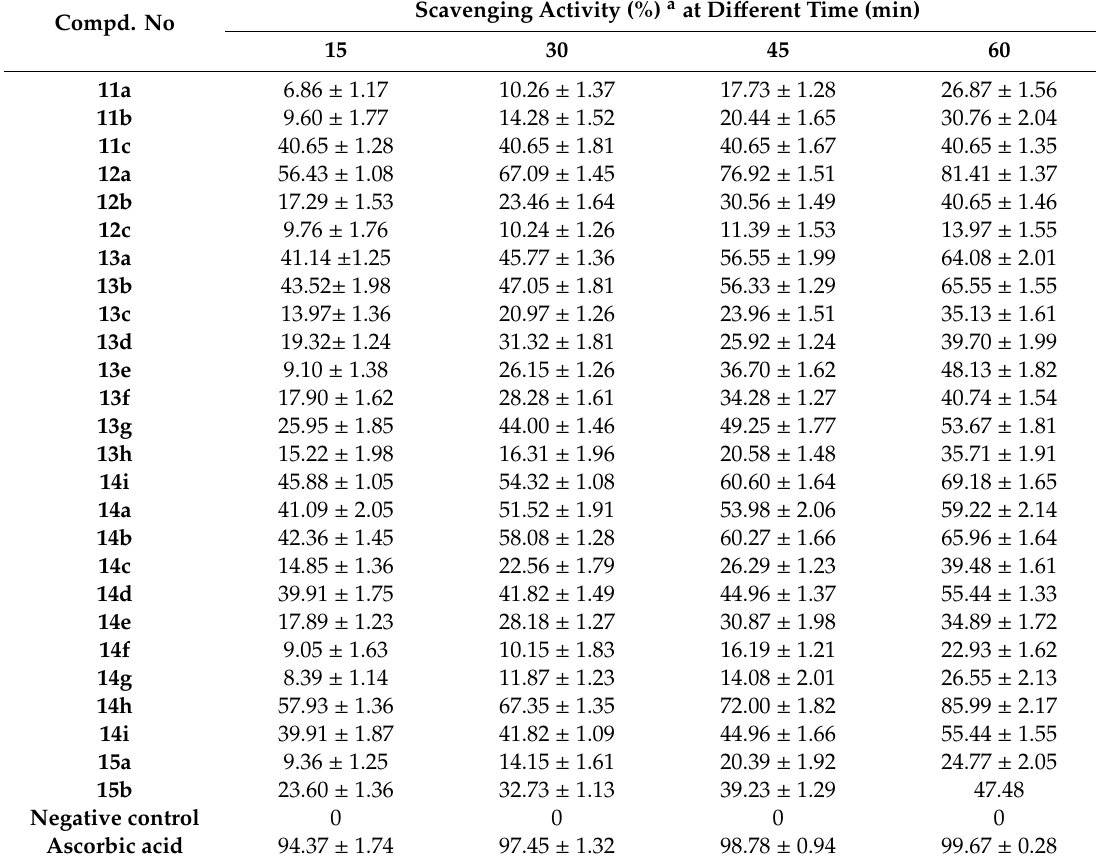
a Results are the mean of three independent experiments. Data = mean ±